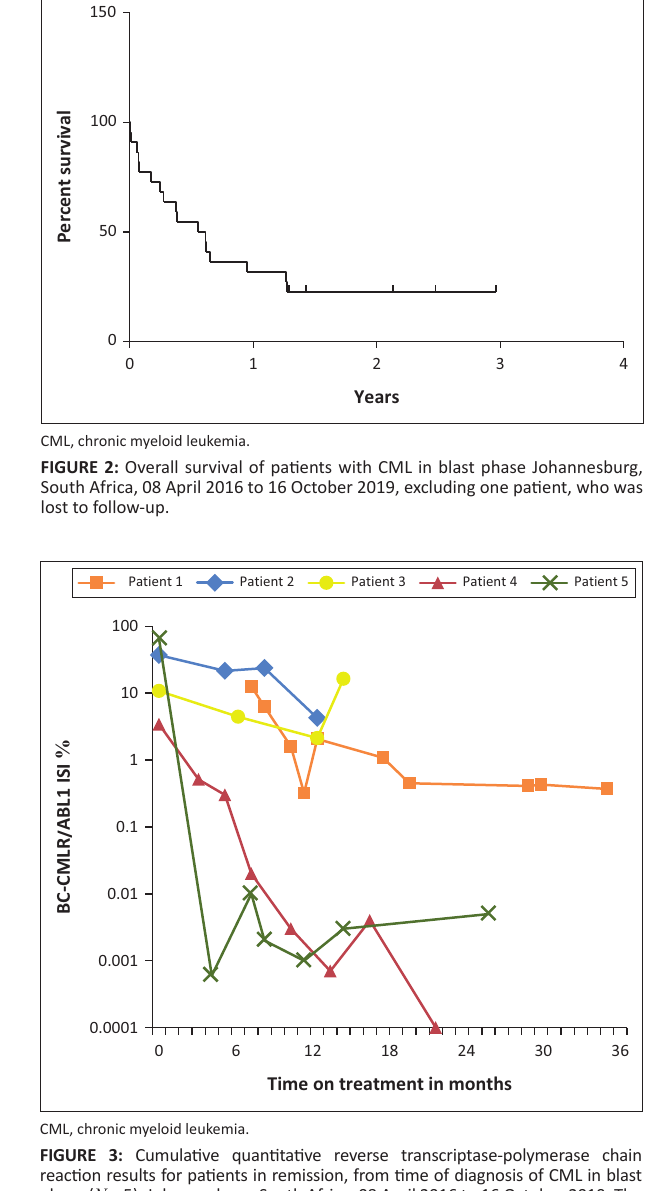
FIGURE 3: Cumulative quantitative reverse transcriptase-polymerase chain reaction results for patients in remission, from time of diagnosis of CML in blast phase ( N = 5), Johannesburg, South Africa, 08 April 2016 to 16 October 2019. The following were the demographics of patients 1 to 5; Patient 1: 51-year-old